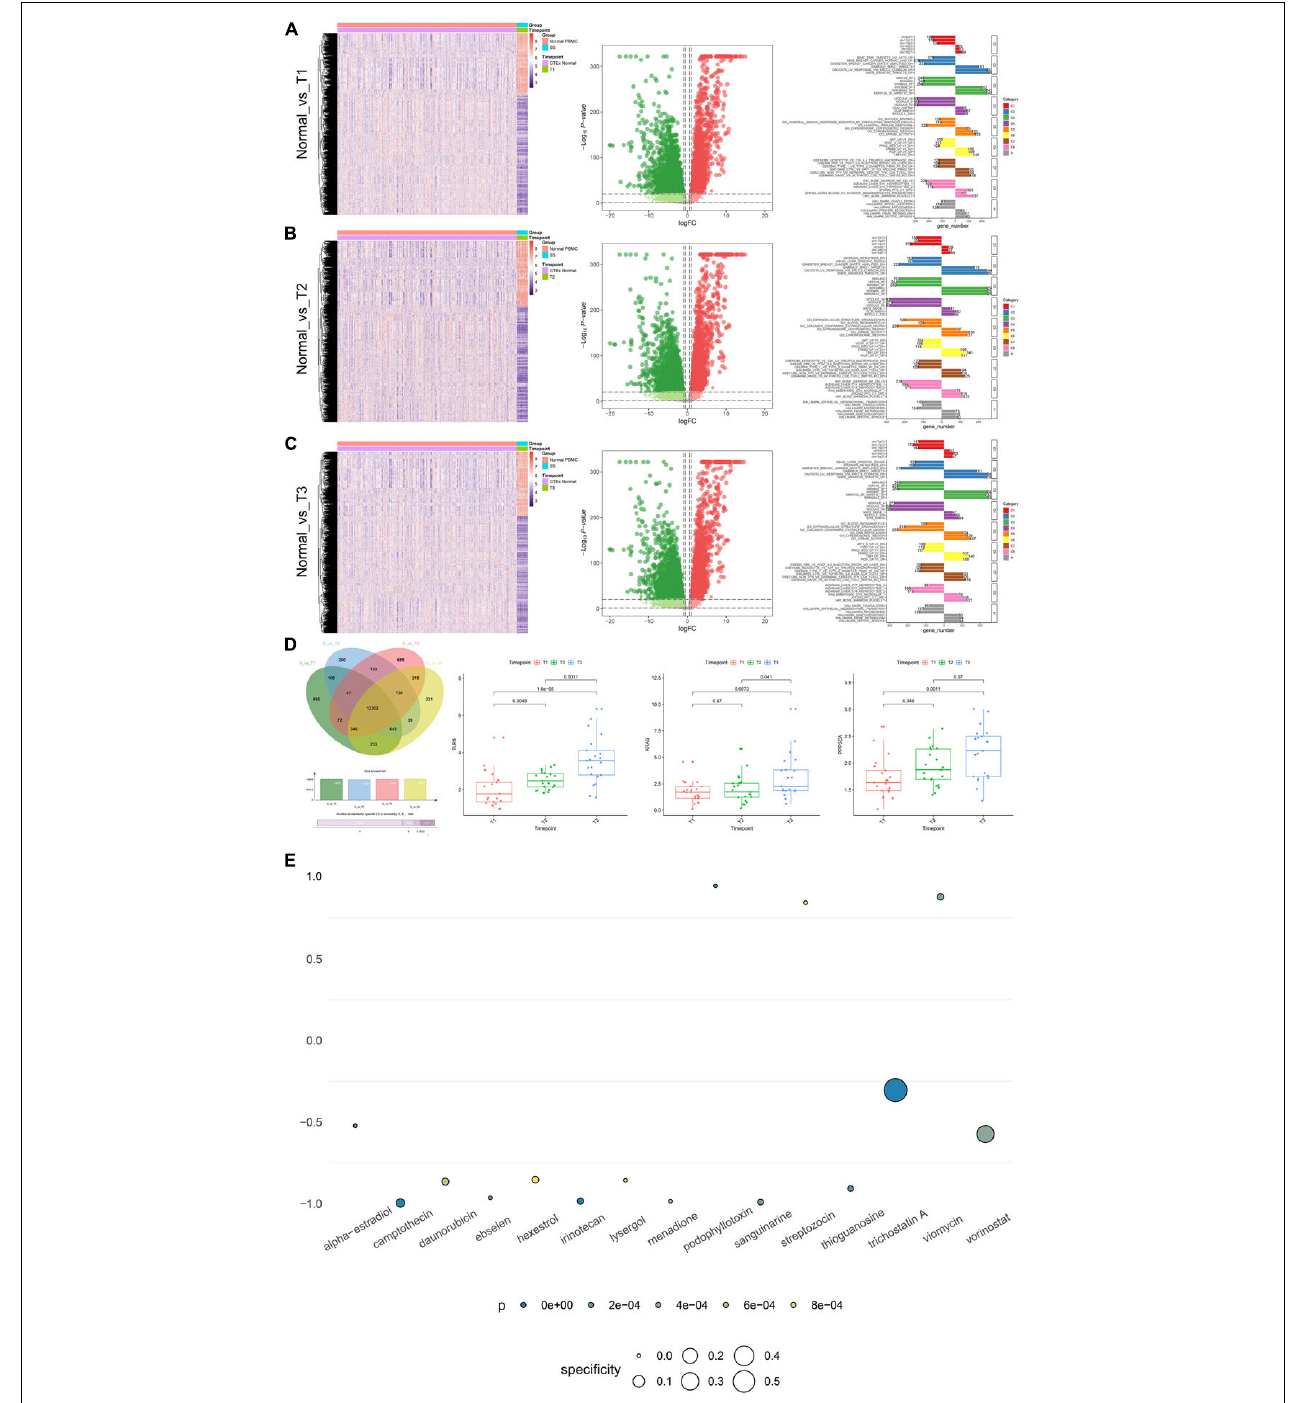
FIGURE 6 | The results of clinical correlation analysis and CMap analysis. (A–C) Significant gene differential expression patterns of the key SSSIRGs identified previously (TLR8, KRAS, and PPP3CA) between normal samples and septic shock patients in different time point groups (T1–T3) are illustrated in the heat maps and volcano plots, respectively; the bar plot showing the DEGs belongs to several gene sets of immune response and inflammation, including immune response mediated by circulating immunoglobulin, humoral immune response gene set, and hallmark coagulation. (D) Venn plot showing 12,302 DEGs that were significantly differentially expressed between normal samples and all time point groups; the box plots of non-parametric test (Kruskal–Wallis H test) showing the three identified key SSSIRGs (TLR8, KRAS, and PPP3CA) were significantly associated with the length of hospital stay (LOS) ( p < 0.050). (E) Dot plot showing 15 potential bioactive small molecules targeting to SSSIRGs including alpha-estradiol, camptothecin, daunorubicin, ebselen, hexestrol, irinotecan, lysergol, menadione, podophyllotoxin, sanguinarine, streptozocin, thioguanosine, trichostatin A, and viomycin and vorinostat ( p < 0.001). Importantly, podophyllotoxin with the highest specificity was considered as the best compound targeting to key